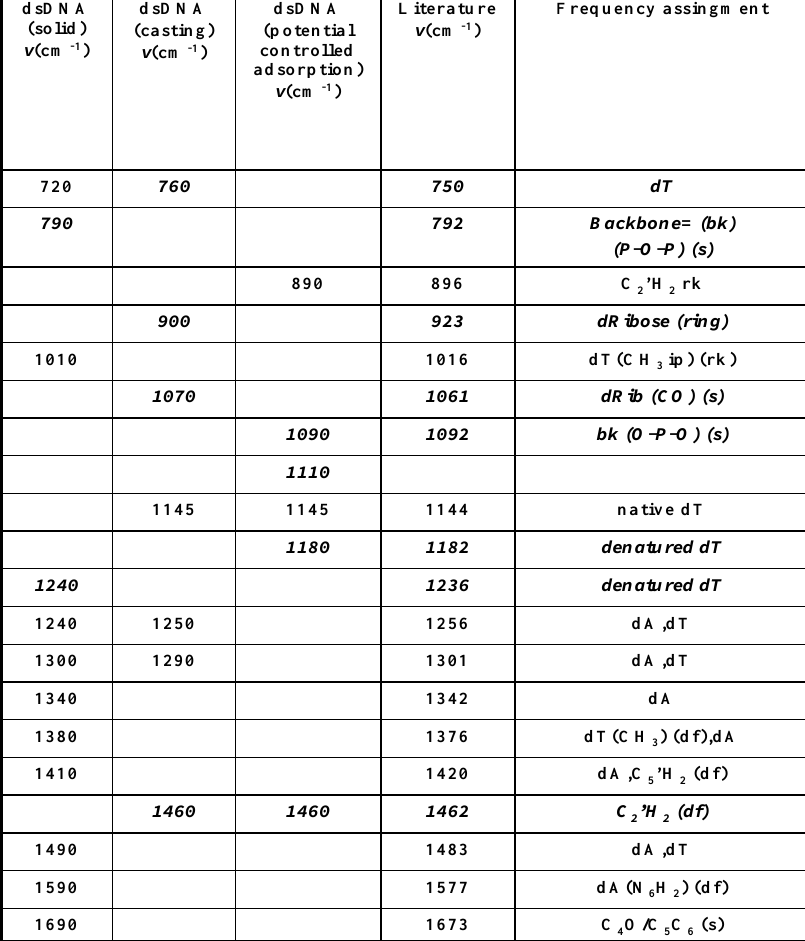
Table 1. Comparison and frequency assignment between Raman bands of the solid dsDNA spectrum, taken as reference (first column), and those of the dsDNA immobilized at the electrode surface by casting the glassy carbon electrode with 10 µL of 1000 ppm dsDNA solution (second column), or by adsorbing the polynucleotide under controlled-potential conditions for full surface coverage (5 min, at 0.20 V from a 10.0 ppm solution) (third column), and the reference spectrum bands informed in the literature [42,43] (fourth column). Abbreviations: dA, deoxyadenosine; dT, deoxythimidine; A, adenine; T, thymine, G, guanine; bk, backbone; s, stretching; b, breathing; df, deformation; rk, rock; ip, in